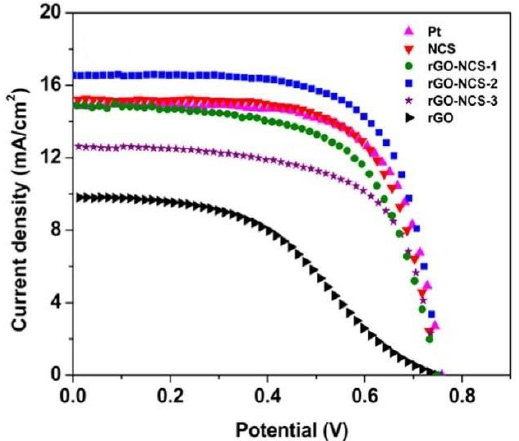
Figure 11. Current-voltage (J – V) characteristics of various DSSCs with different CEs under simulated AM 1 G solar light. Reproduced with permission from Reference [16], Elsevier 2017.